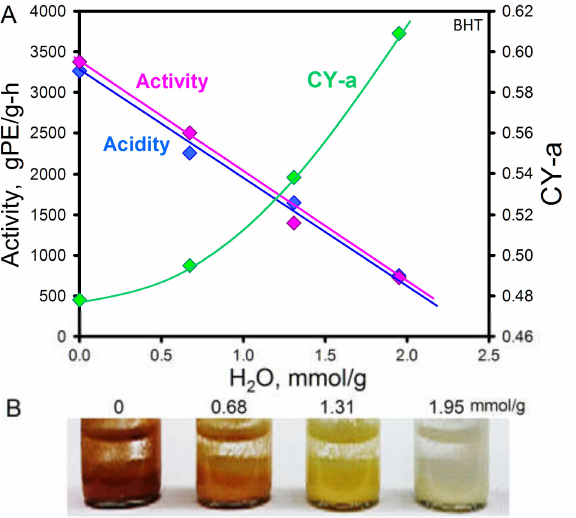
Figure 9. (( A ), above): Activity and LCB from a metallocene catalyst supported on sulfated alumina declines (CY-a rises), as water is added to the solid acid. (( B ), below): color generated when the treated solid acid is treated with